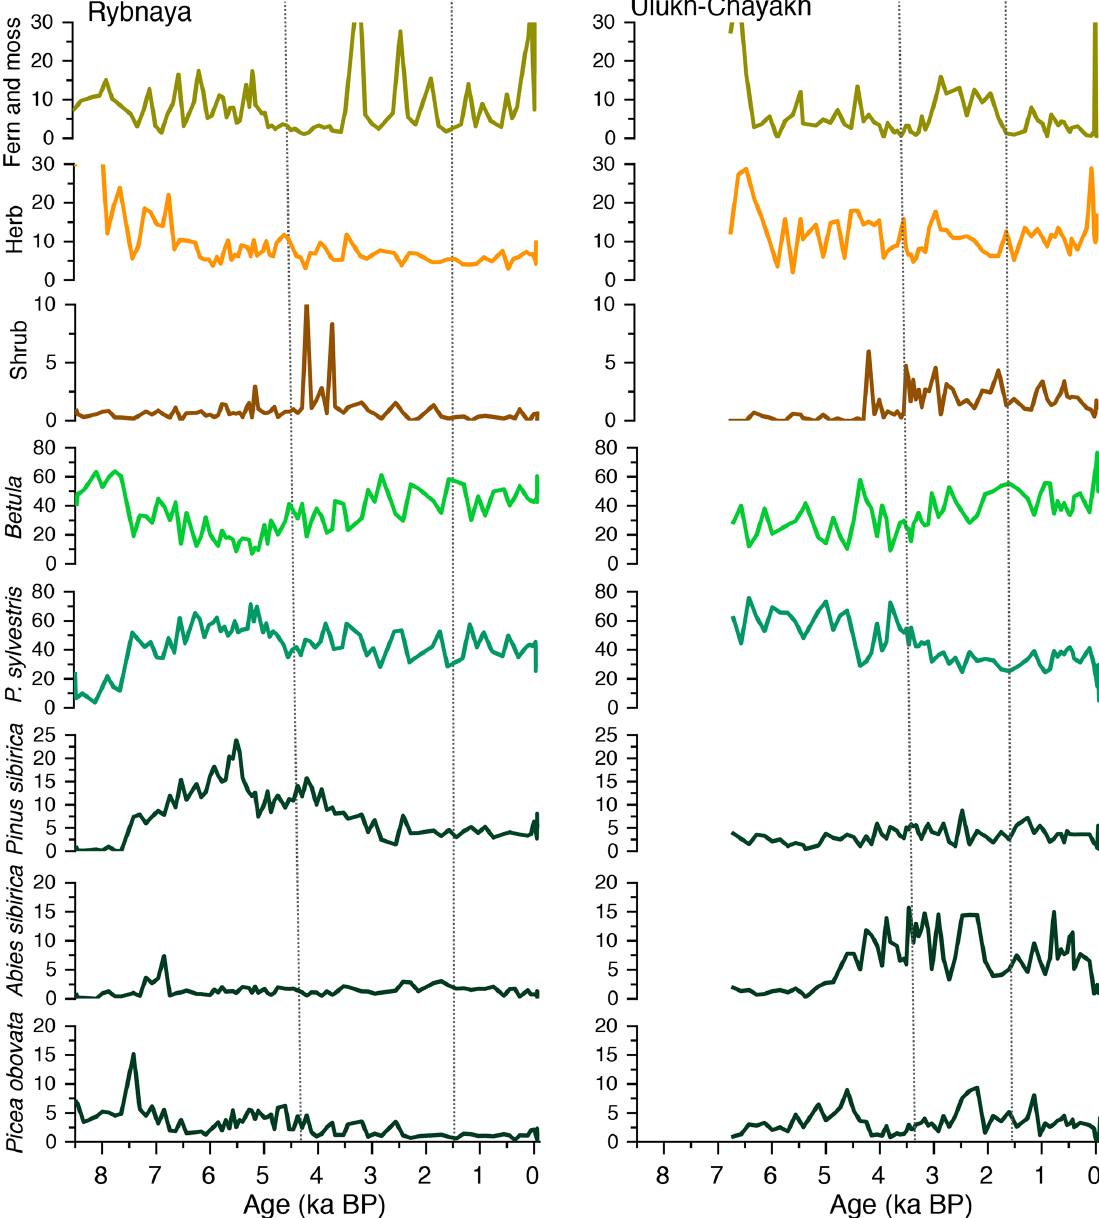
Figure 3. Temporal trends in the pollen and spore percentages of individual tree taxa and lumped group-wise for shrub, herb, fern, and moss at Rybnaya and Ulukh–Chayakh. Periods with substantial changes in fire regime are indicated by the dotted vertical